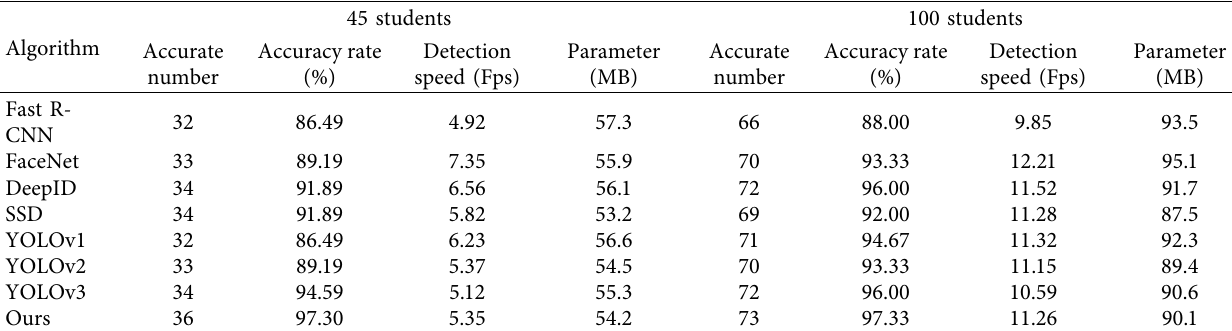
Figure 7: Face detection results of this algorithm. (a) Original image ( 1280 ∗ 960 ) . (b) A low-pixel image ( 320 ∗ 240 ) . (c) Image reconstructed by ( 640 ∗ 480 ) . (d) Image reconstructed by ( 960 ∗ 720 ) . Table 6: Test results of self-built classroom